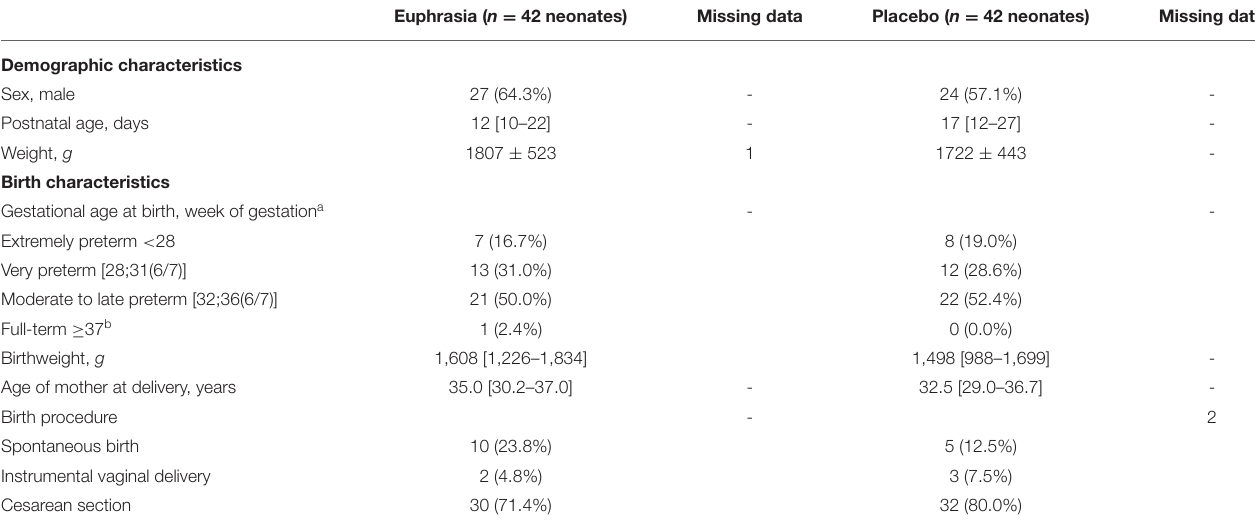
TABLE 1 | Baseline characteristics ( n = 84 neonates). Euphrasia ( n = 42 neonates) Missing data Placebo ( n = 42 neonates) Missing data